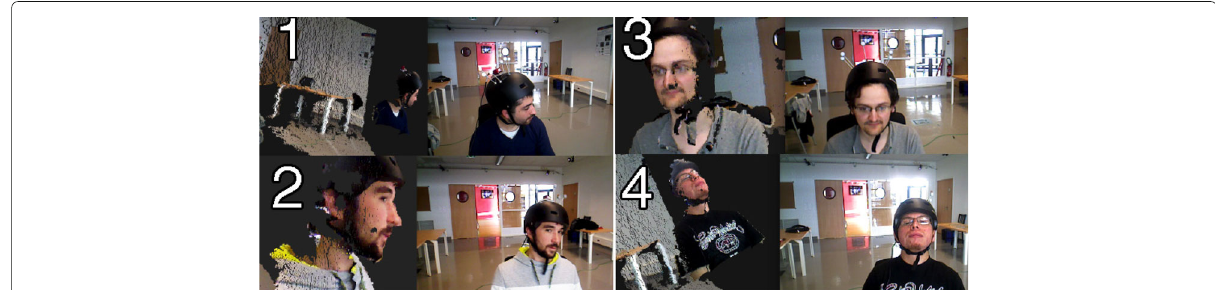
Fig. 5 Example of the 4 sequences of our dataset. The images show the 3D point cloud (on the left) and the RGB image (on the right) for each sequence. NOTE: panel label only enumerates the sequences